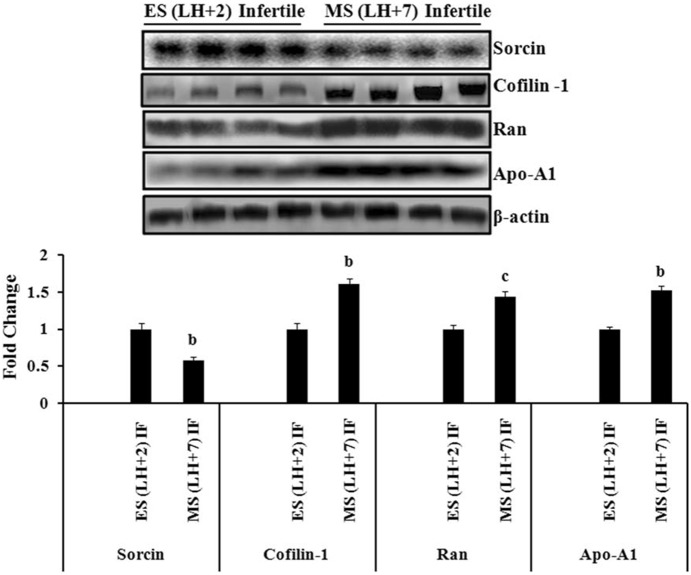
Validation of Sorcin, Cofilin-1, Apolipoprotein-A1 (Apo-A1) and Ran GTP-binding nuclear protein (Ran) in infertile women.Expression of Sorcin, Cofilin-1, Apo-A1 and Ran were analyzed by western blot analysis in early-secretory (LH+2) and mid-secretory phase (LH+7) endometrium of infertile women, which had not been previously analyzed in the 2D-PAGE analysis. The results matched the findings of 2D-PAGE analysis. Representative images (upper panel) of immunoblot of Sorcin, Cofilin-1, Apo-A1 and Ran have been shown. β-actin served as a loading control for normalization. Quantification of band intensity (lower panel) was performed by densitometric analysis by using Quantity One software (v. 4.5.1) and a Gel Doc imaging system (Bio-Rad). P values are (b) p<0.01 and (c) p<0.05 versus early-secretory phase (LH+2). Values are expressed as mean± SE; n = 4. ES = early-secretory phase, MS = mid-secretory phase, LH+2 = 2 days after luteinizing hormone surge, LH+7 = 7 days after luteinizing hormone surge.